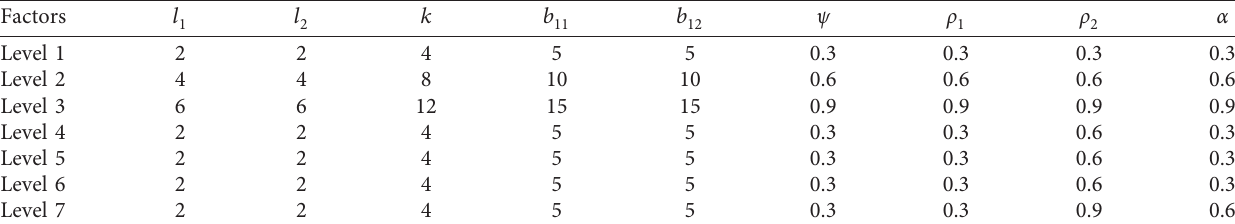
Table 5: The value range of the relevant factors.